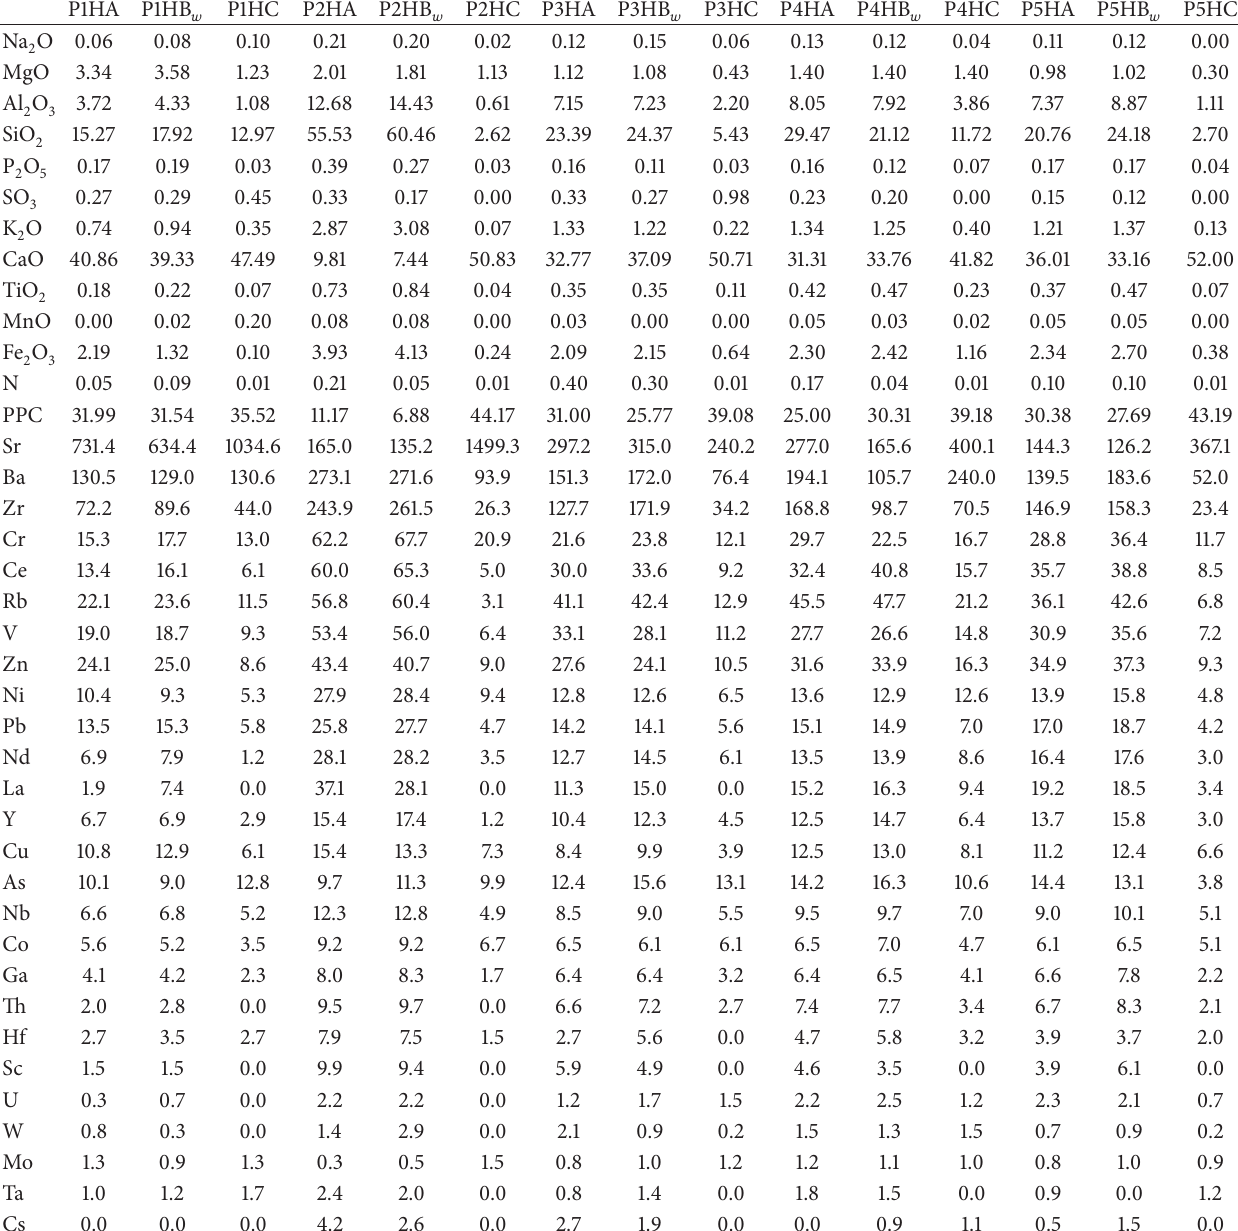
Table 3: Major elements, from Na O to N (%), and trace element contents in each horizon. PPC = losses for calcination. Mean data ( 𝑛 = 3 2